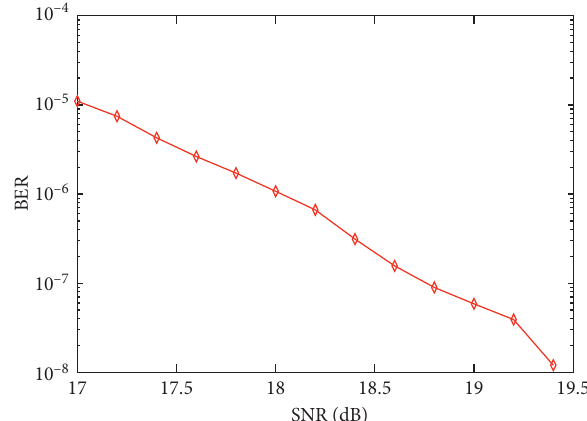
Figure 10: Bit error rate (BER) versus SNR for an 8QAM OFDM- based receiver.